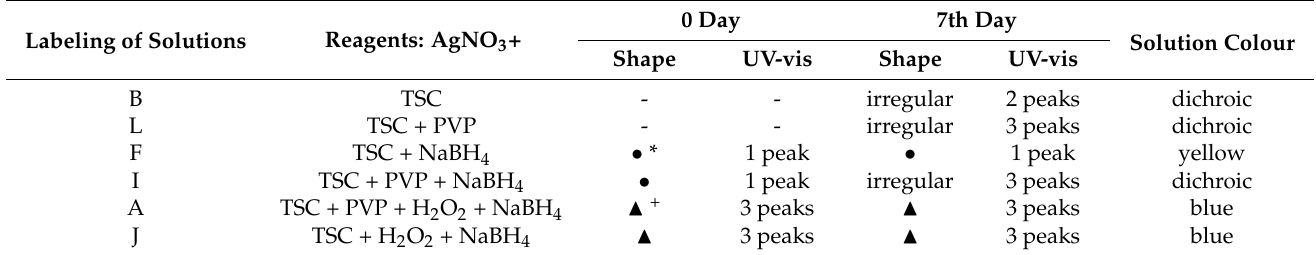
Table 2. Summary of experimental results for solutions with